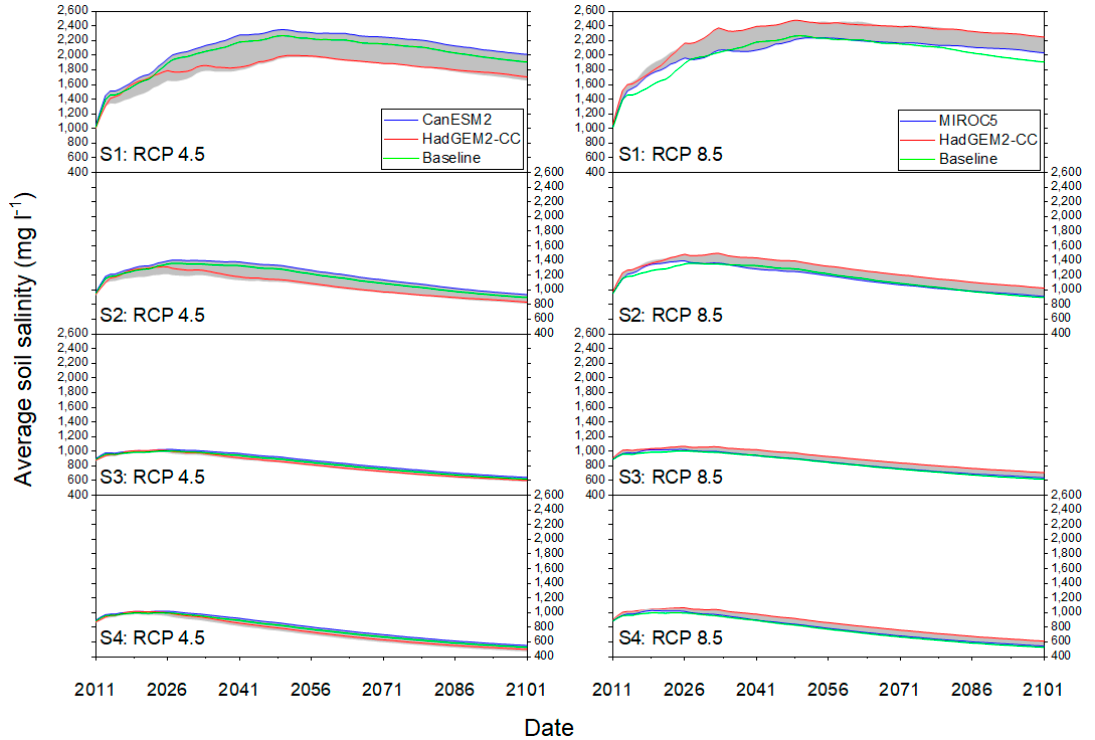
Figure 9. The average soil profile salinity across different partial afforestation configurations and RCP scenarios considered in this study.